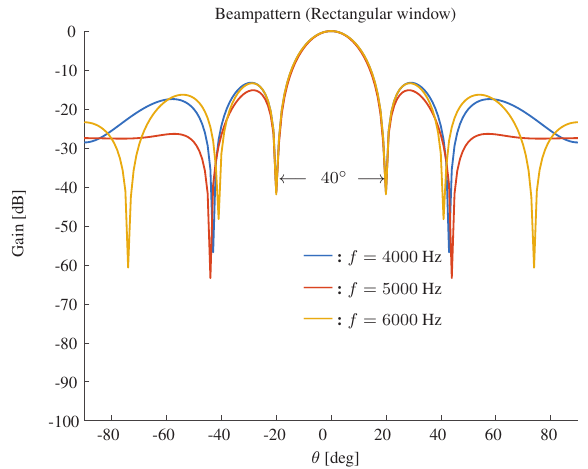
Figure 3. Constant beamwidth beampattern using a modified rectangular window. The beamwidth is fixed to 40 ◦ , M = 11, δ = 3.5